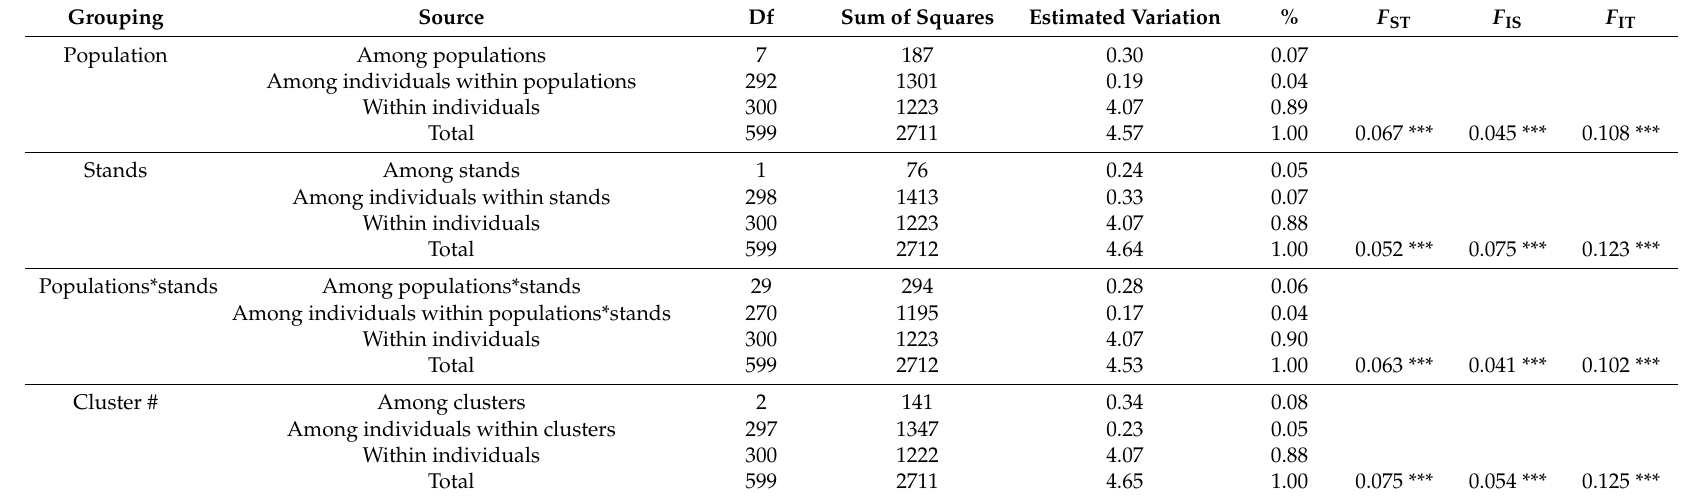
Table 7. Analysis of molecular variance (AMOVA) based on microsatellite loci genotyped in eight populations of sea buckthorn in the Gilgit and Baltistan regions, northern